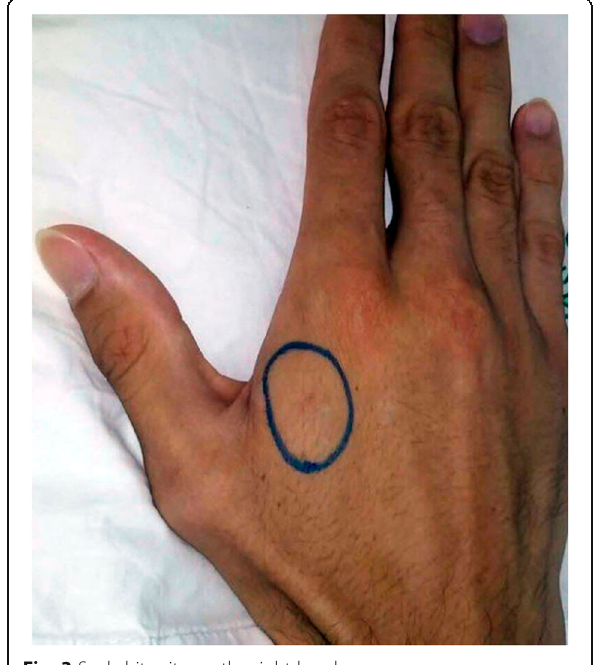
Fig. 3 Snakebite site on the right hand